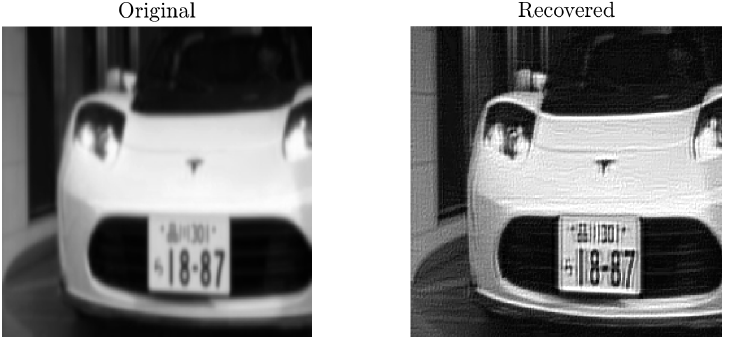
Figure 19. Result on deblurring an image that does not belong to a training set of blurred images.